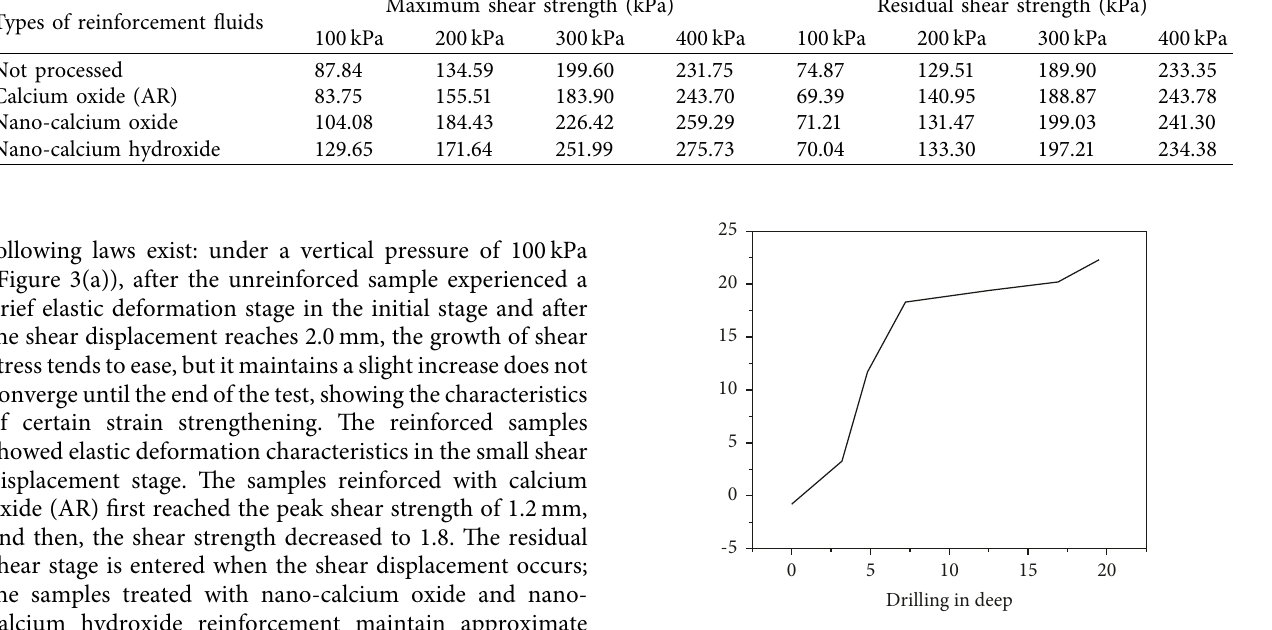
Figure 4: Drilling resistance curves of treated and untreated samples with different calcium-based